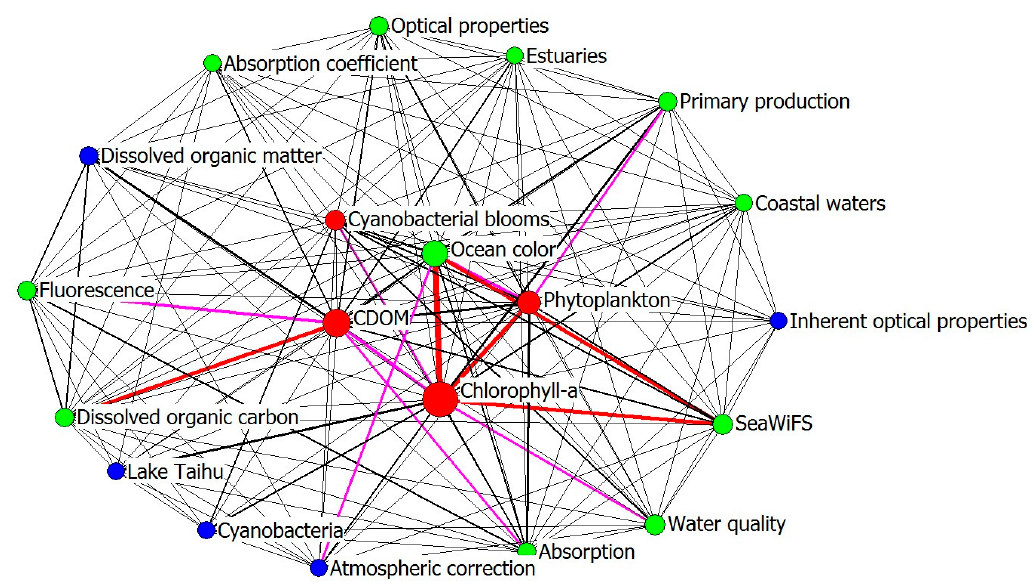
Figure 1. Co-word network of high-frequency keywords in water optics and water colour remote sensing research. The size of lines represents the number of co-occurrences. The colour of lines represents the group of the co-occurrences number: red ≥ 50; 25 ≤ magenta < 50; black ≤ 25. The size of nodes represents the keyword frequency; the colour of nodes represents the group of the number of connections to other nodes: red = 20; 15 ≤ green < 20; 10 ≤ blue < 15.